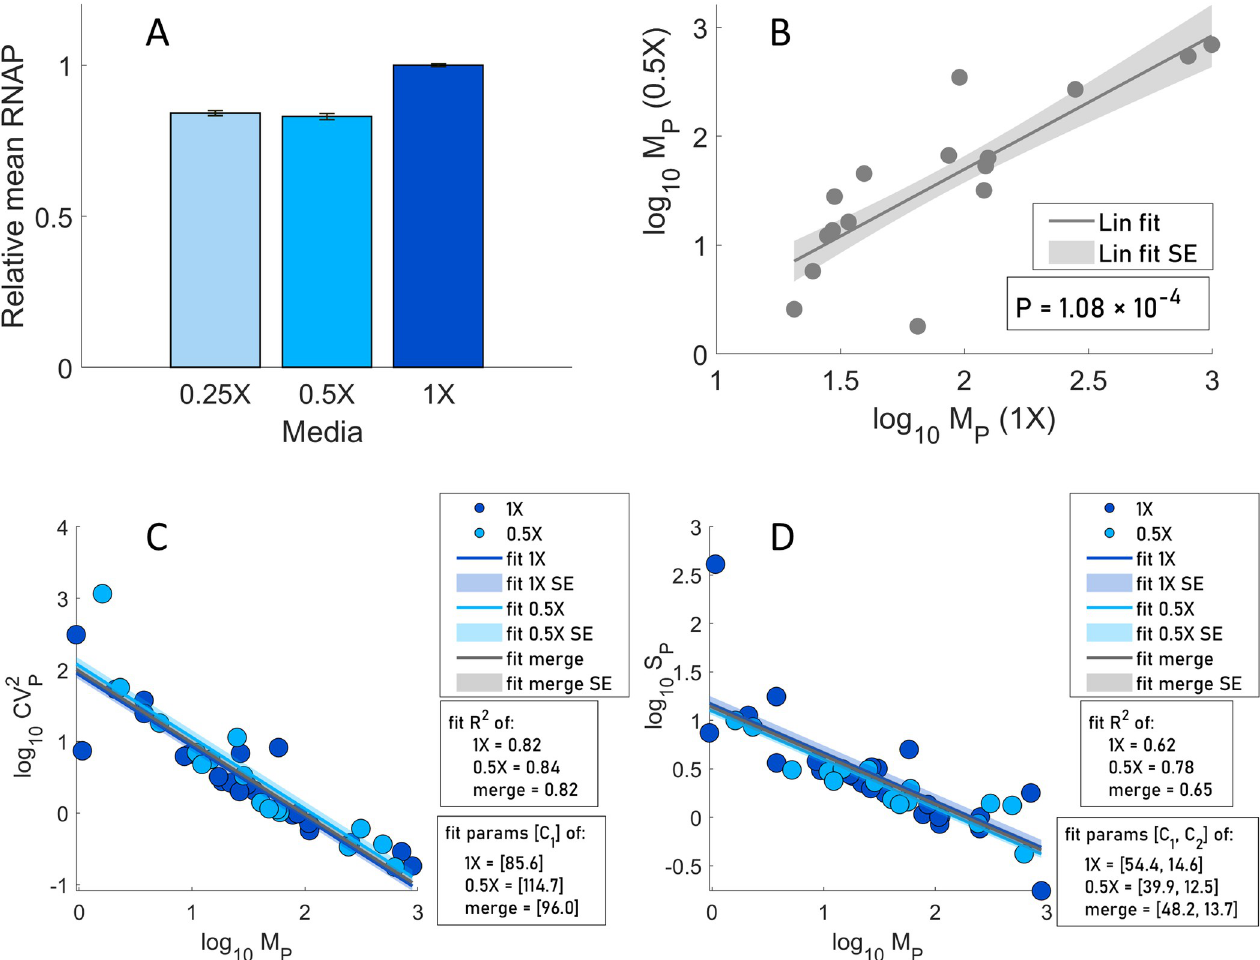
Fig 5. Relative RNAP concentrations along with the relationships between the moments of the single cell distributions of protein numbers. (A) Relative RNAP levels measured by flow-cytometry (Section ‘flow-cytometry and data analysis’ in the S1 Appendix) in three media. (B) Scatter plot between M P in M9 (1X) and diluted M9 (0.5X) media. Also shown are the best fitting line and standard error and p-value for the null hypothesis that the slope is zero. (C) M and (D) M vs S of single-cell protein numbers of genes with tandem promoters in M9 (1X) and M9 diluted (0.5X) media. The lines and their shades are CV 2 P P P the best fitting lines and standard errors, respectively. ‘Merge’ stands for data from both 0.5X and 1X conditions.